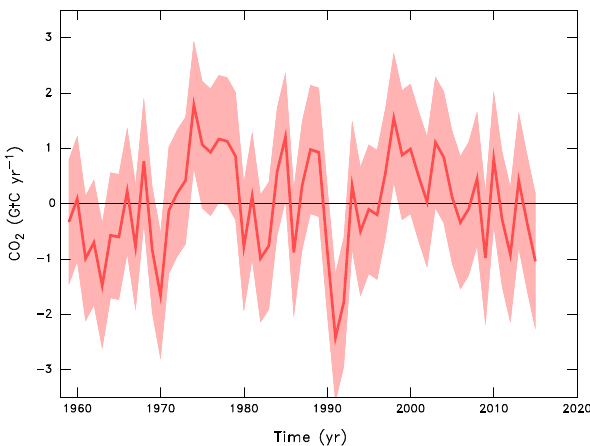
Figure 10. Unaccounted carbon in the global carbon budget (GtCyr − 1 ). This is calculated as the sum of G ATM plus S OCEAN minus E FF and E LUC as described in Fig. 4, plus S LAND as esti- mated with the ensemble of DGVMs as in Fig. 6b. Therefore, the unaccounted carbon represents the fluxes that are missing after ac- counting for all known processes as quantified in available estimates (see discussion). The uncertainty is the annual uncertainty for the five terms as described in the text, added in quadrature. Positive values indicate an unaccounted surface-to-atmosphere flux of CO 2 or an underestimation of the